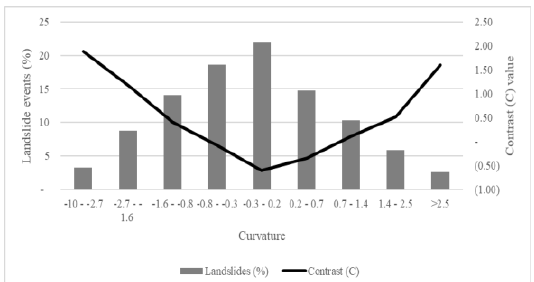
Figure 4 Landslide distribution (%) (left vertical axis) and contrast value (right vertical axis) in different curvature ranges.